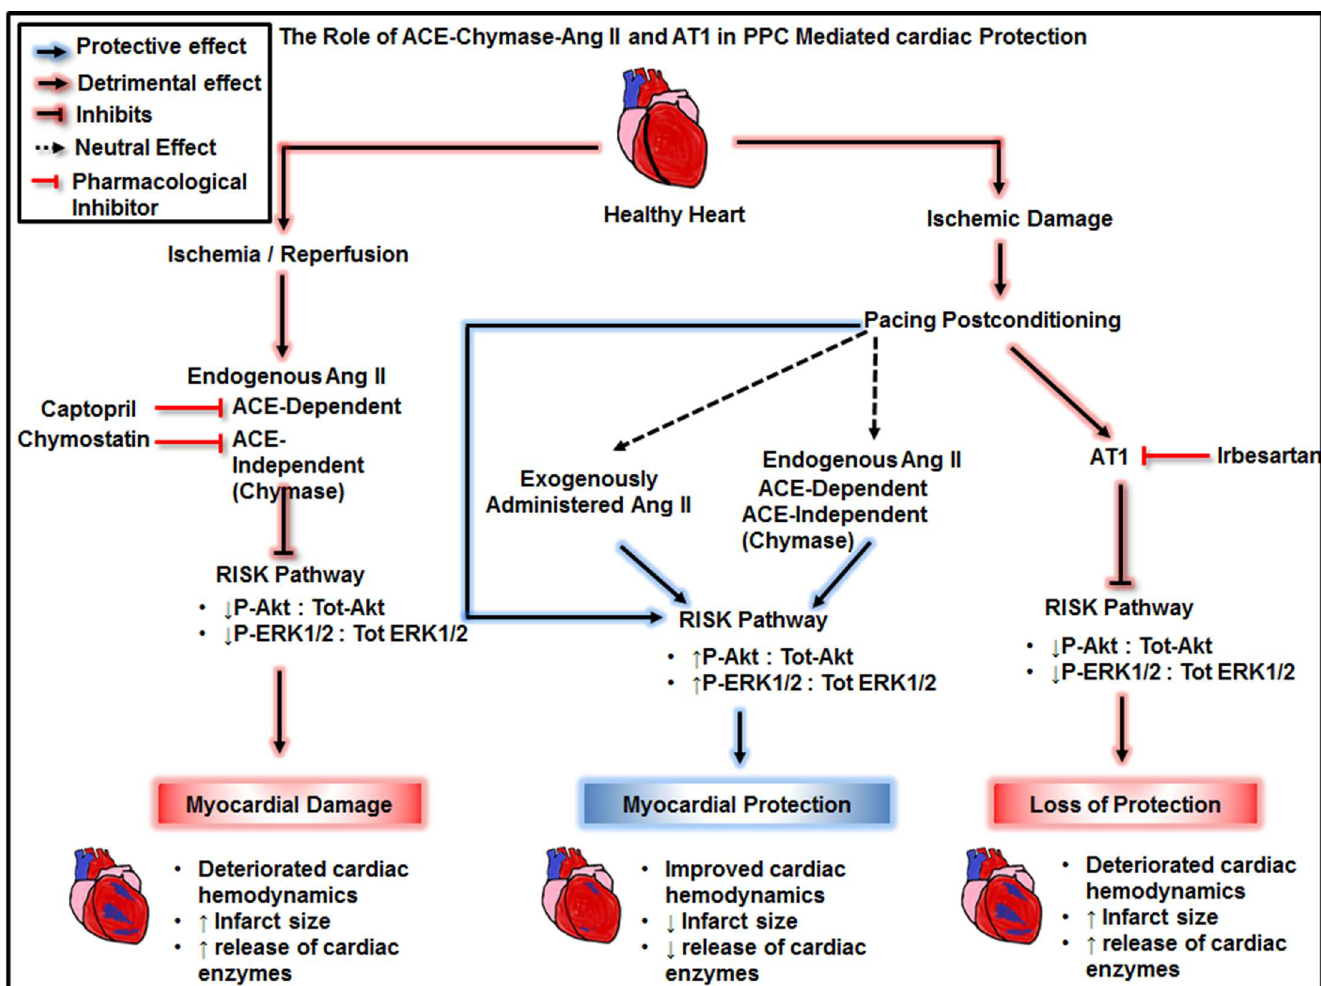
Fig 6. Proposed mechanism of the interaction between ACE-Chymase-Ang II-AT1, I/R injury and PPC mediated cardiac protection. Ischemia/ reperfusioninduced cardiac injury characterizedby impaired cardiac hemodynamics, increasedinfarct size and enhancedrelease of cardiac enzymes, LDH and CK, involvedACE and chymase mediated productionof Ang II and reduced activation of ERK1/2 and AKT components of the RISK pathway. PPC on the other hand improved cardiac hemodynamic and attenuated infarct size and release of cardiac enzymes. PPC protectioninvolved downstream signalingvia the RISK pathway. Exogenous administration of Ang II or blockageof endogenous Ang II had a neutral effect on PPC mediated cardiac protection yet induced the RISK pathway. AT1 antagonist, irbesartan on the other hand abrogated the protective effects of PPC and attenuatedthe RISK